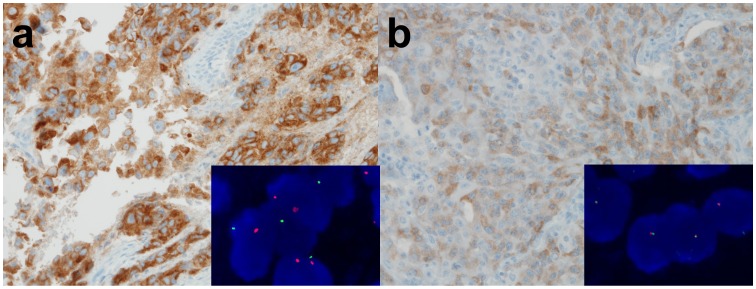
Representative photos from ALK IHC.An ALK-rearranged tumor shows strong and diffuse staining (a) (inset: ALK FISH with split signals). In contrast, an ALK-non-rearranged tumor shows weak and patchy staining (b) (inset: ALK FISH without split signals).